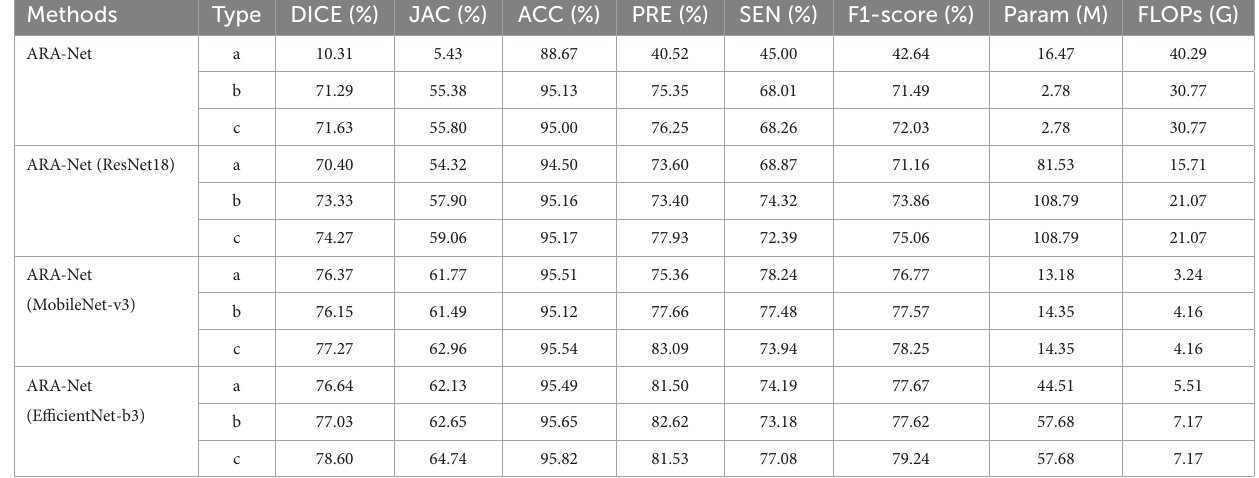
TABLE 1 Performance comparison, number of parameters, and FLOPs of different models for ablation experiments.